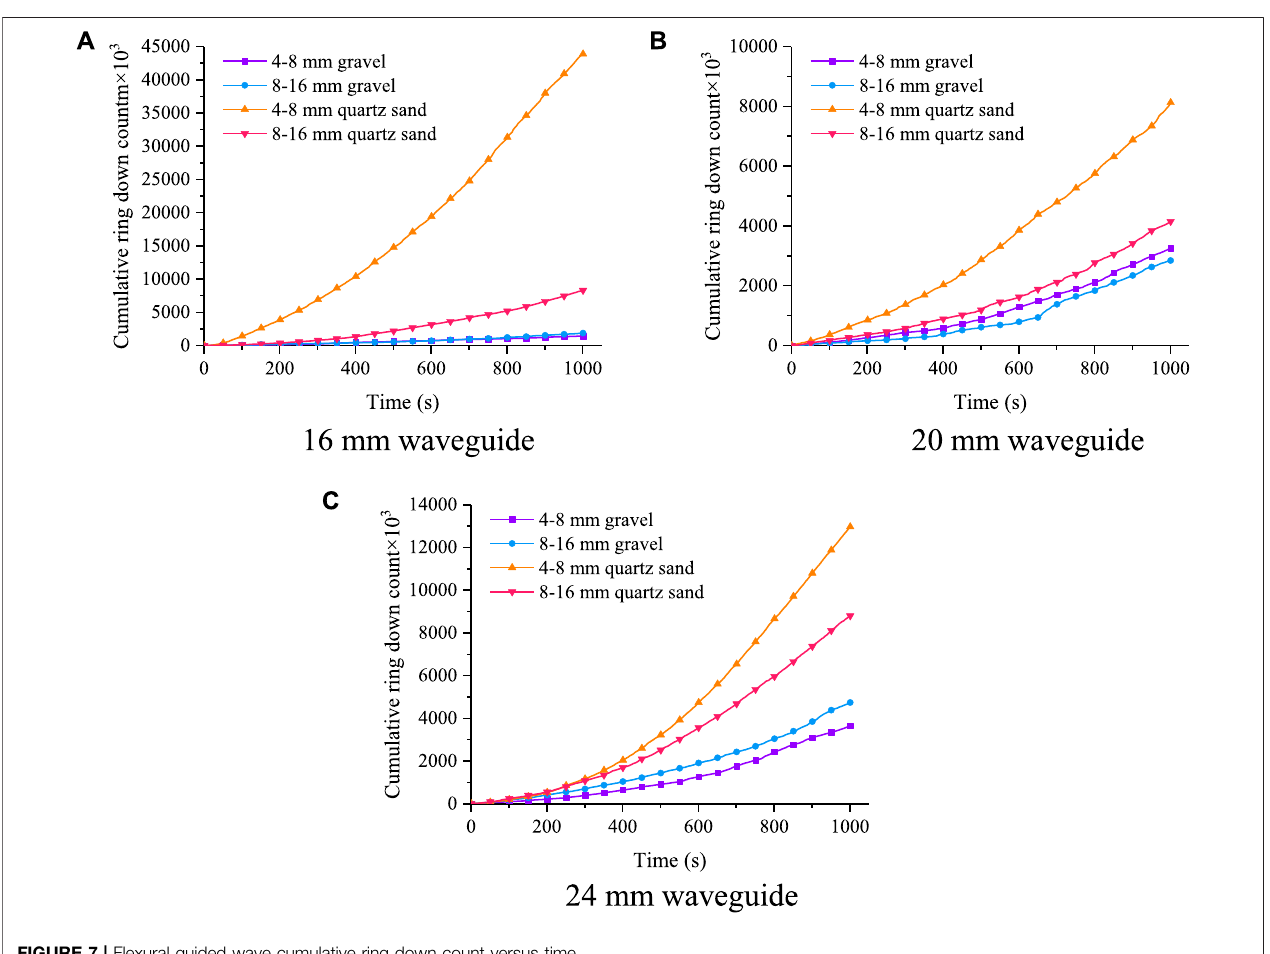
FIGURE 7 | Flexural guided wave cumulative ring down count versus time.